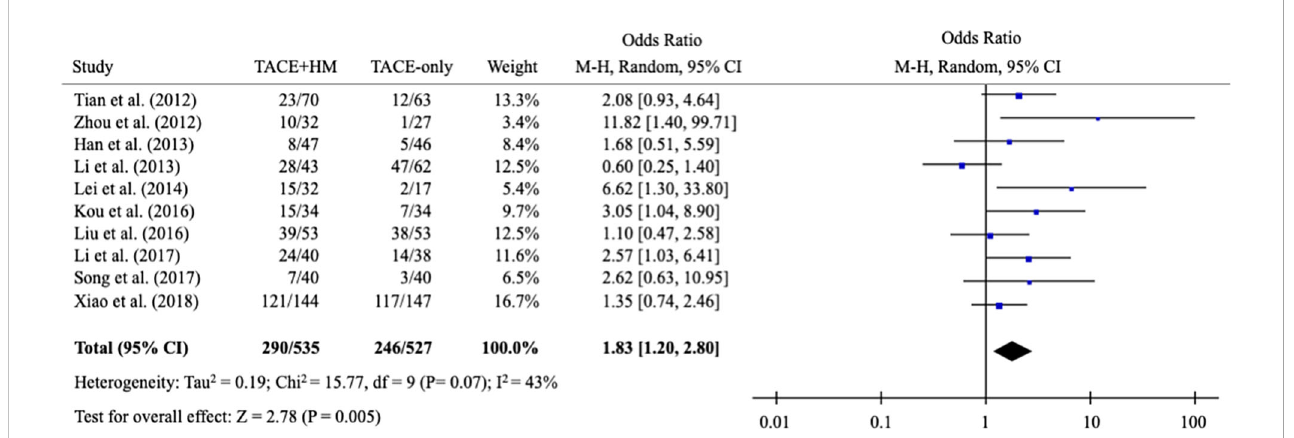
FIGURE 5 Meta-analysis of overall survival at 24-month.